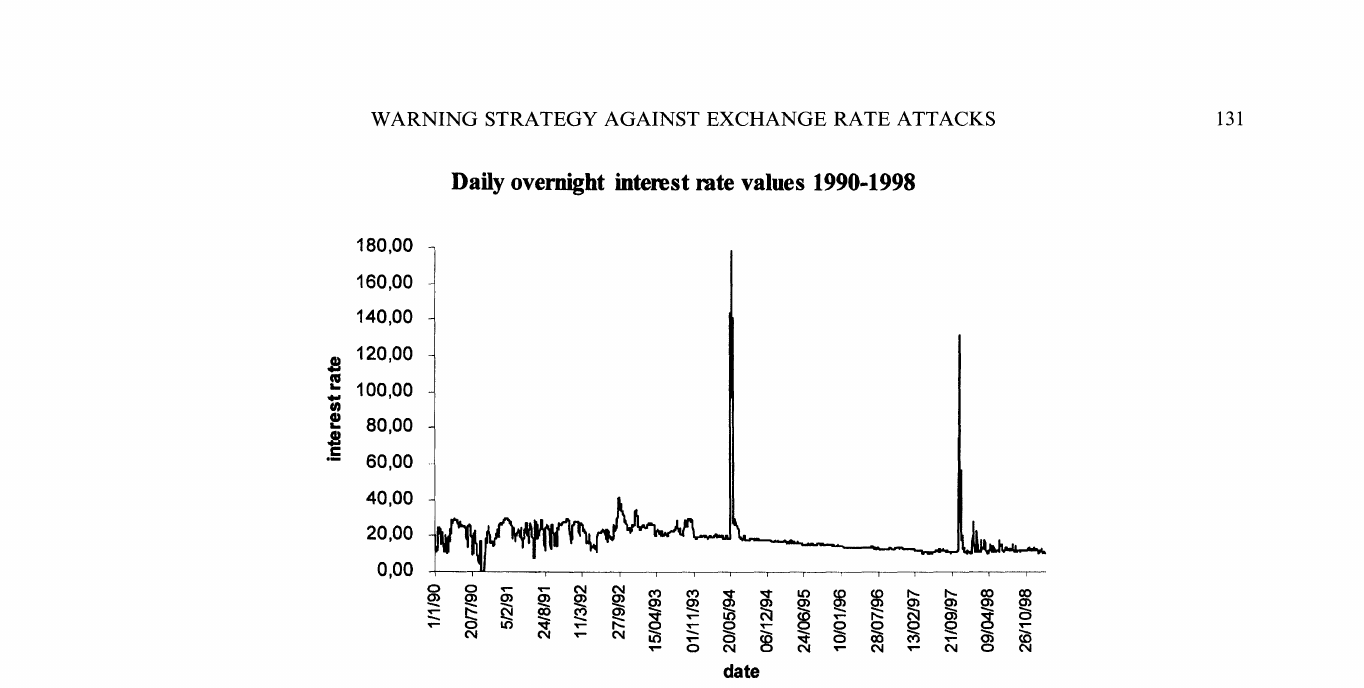
FIGURE 3 Daily values for the Greek overnight interest rate. Sharp peaks correspond to periods of attacks against the